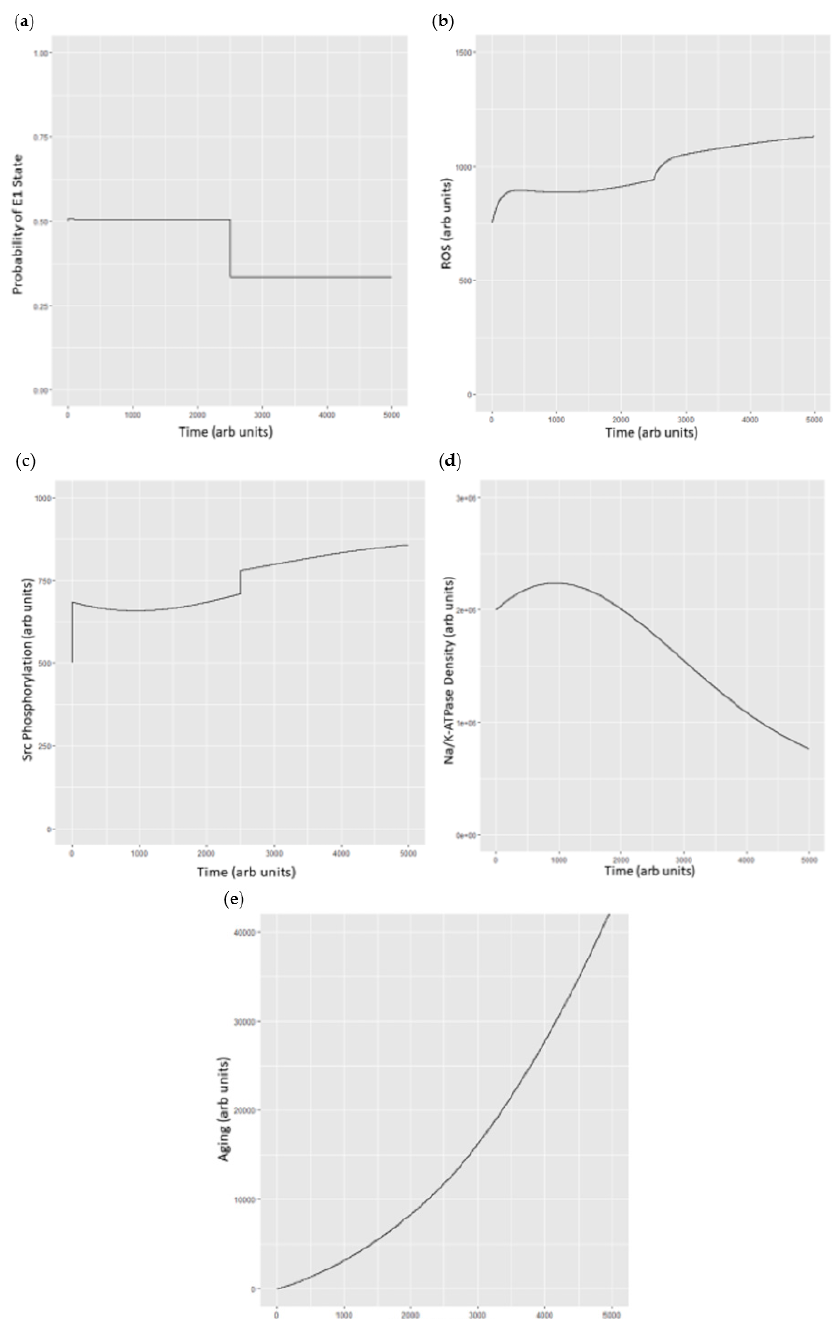
Figure 6. ( a ) Probability of the E1 state under basal conditions and then with the simulated addition of ouabain at 100 µM (approximately 10% of the IC 50 ) at time = 2500; ( b ) simulated changes in ROS under basal conditions and after addition of simulated ouabain at time = 2500. Units of ROS are arbitrary; ( c ) Src phosphorylation as total phosphorylated Src vs. time with conditions described above. Src concentrations are arbitrary beyond the understanding that ½ of the Src pool is under control of the Na/K-ATPase and ½ is not; ( d ) plasma Na/K-ATPase under basal conditions and following addition of ouabain which stimulates endocytosis (at t = 2500); and ( e ) cell aging as a function of ROS with ROS generated through the Na/K-ATPase oxidant amplification loop and Na/K-ATPase endocytosis set to be approximately 1000 times as efficient and inducing “aging”, as we have recently described [32].